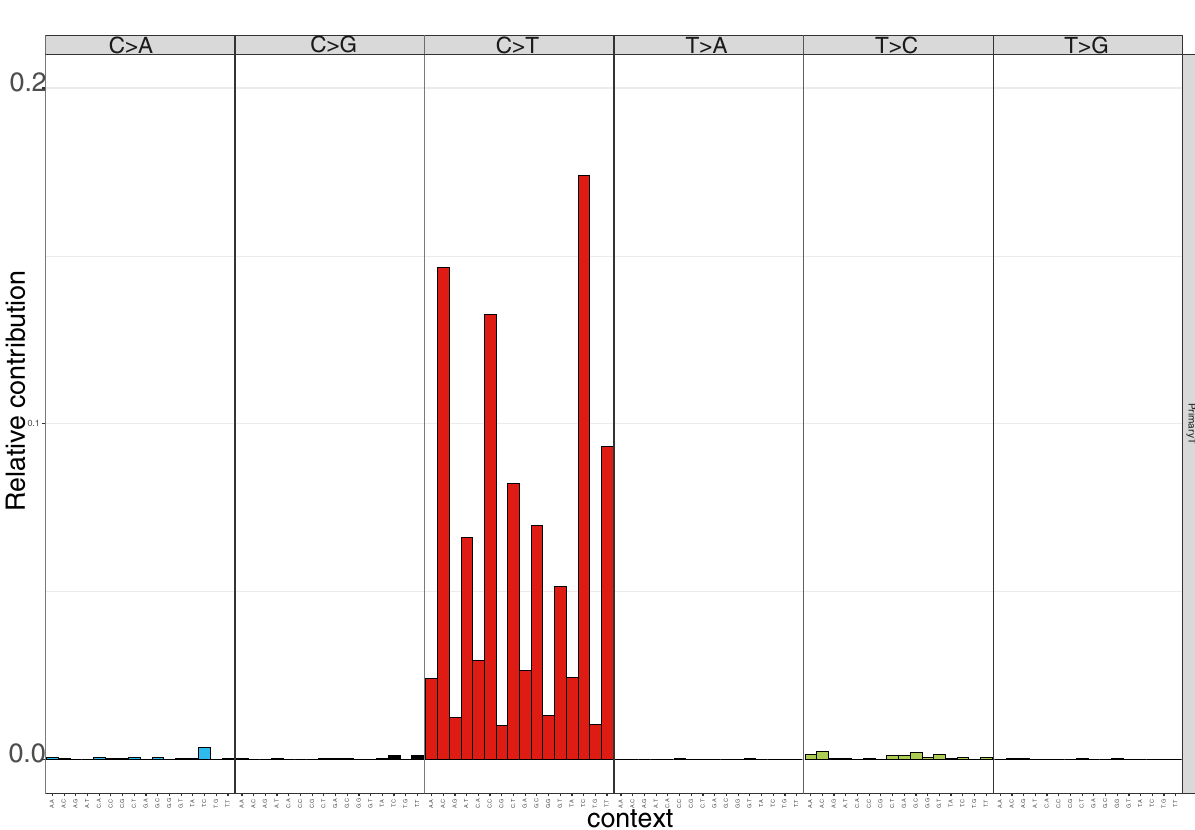
Fig. 3 Mutational signature plot of SNV in the resected spinal tumor specimen. There was an overwhelming prevalence of C>T, with a SNV transition ratio of 96%, consistent with a hypermutated